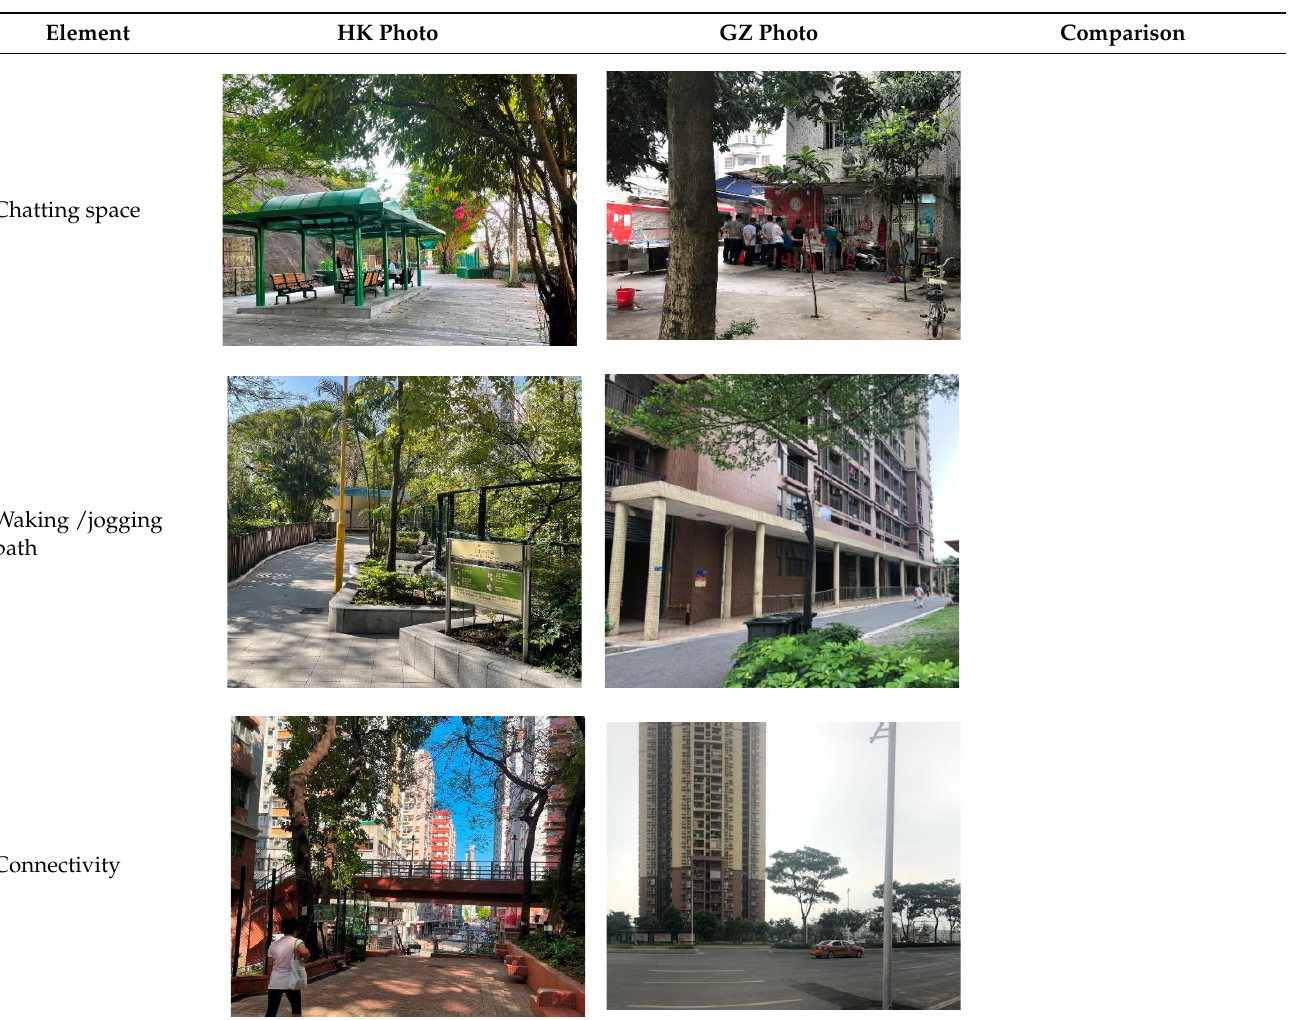
15 of 19 Table 6. Photo comparison of common open space between HK and GZ.